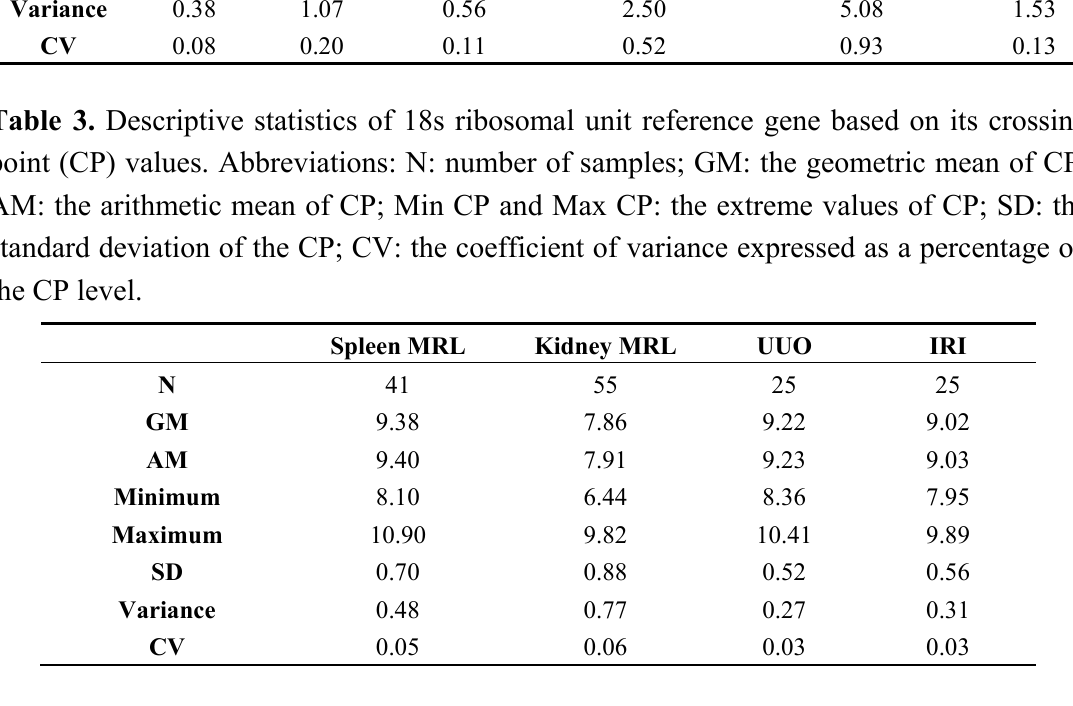
Table 4. Gene-specific primers with example efficiencies (shown for the pooled various organs cDNA samples) and accessions